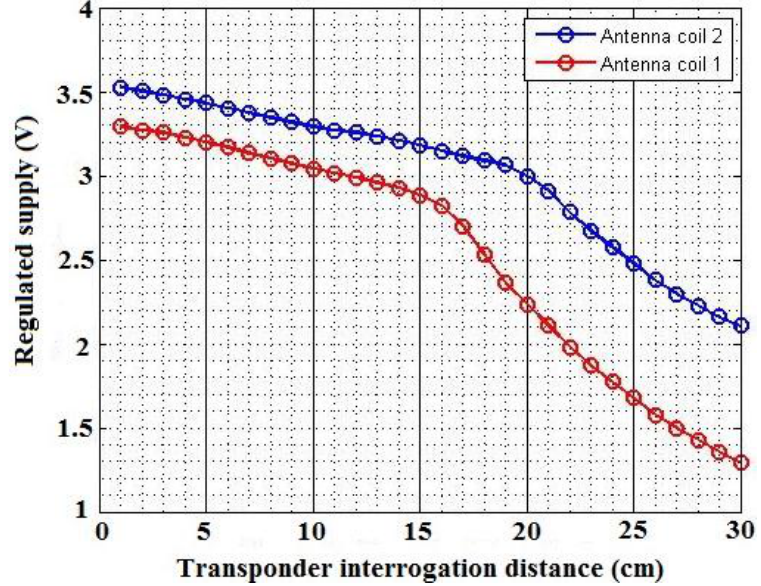
Figure 10. The voltage regulation with regards to the interrogation distance.